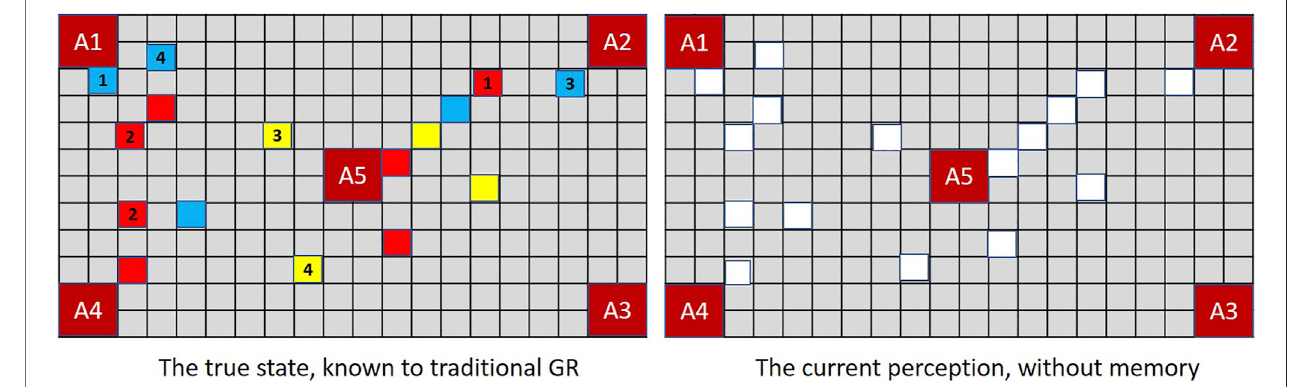
FIGURE7| AtraditionalGRsystem (left) recordstheMindTrailsboardcorrectly,asifalltokenswereface-up.Ahuman — andextendedGR — dependson currently perceived data (all face-down) and recalled observations, which are subject to decay. Only those perceived most recently and with the greatest magnitude are likely to